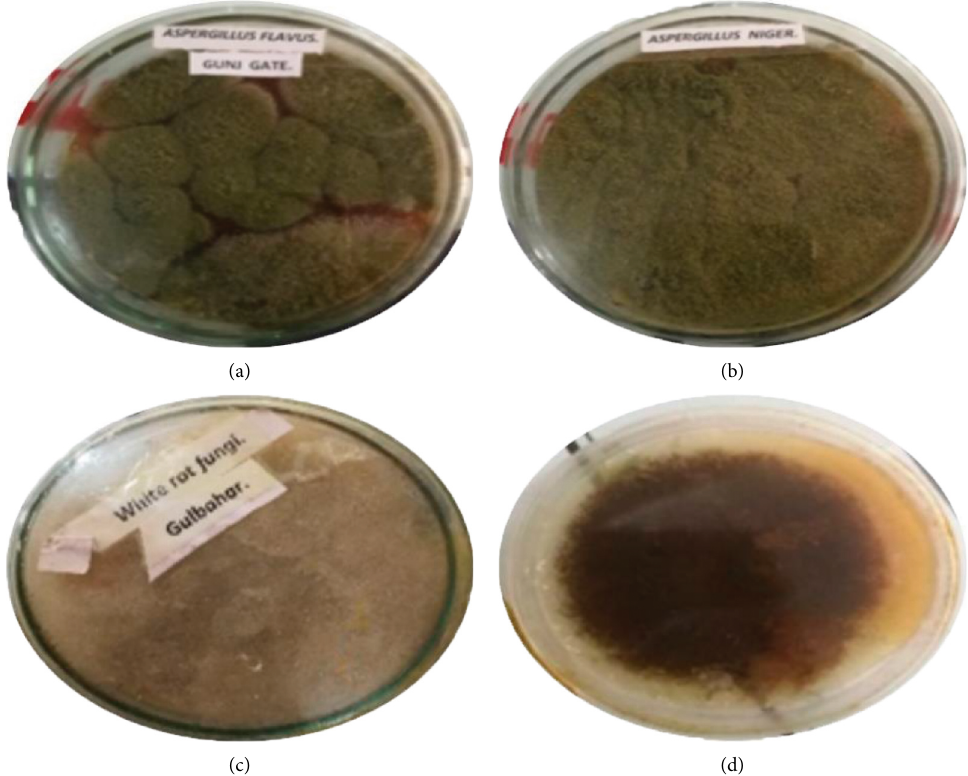
Figure 1: Different isolated colonies of fungi on (a, b) sabouraud dextrose agar medium and (c, d) on potato dextrose agar medium. (a) Aspergillus flavus . (b) Aspergillus niger . (c) White rot. (d) Brown